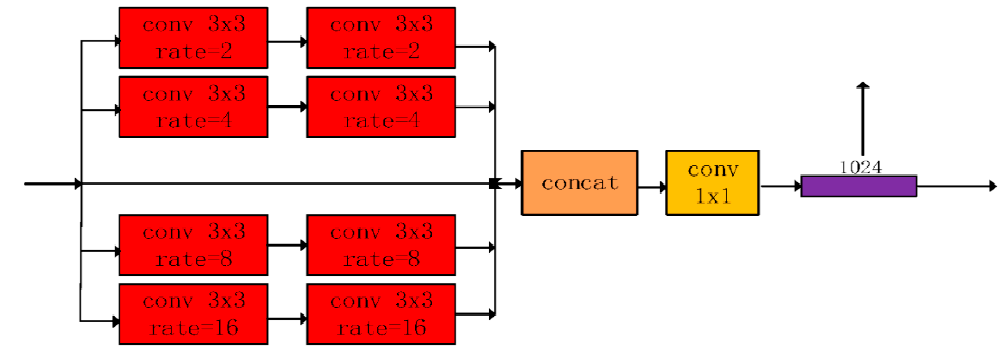
Figure 4. The overview of the multi-dilation module.